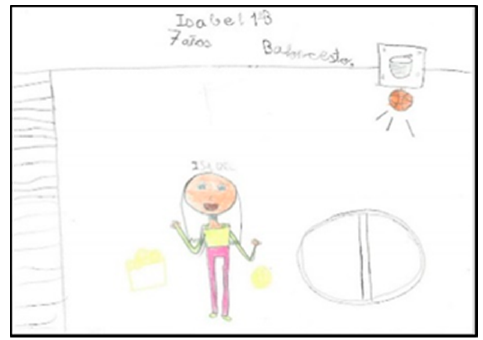
Figure 16. Number of figures present. Martina. 2°B.